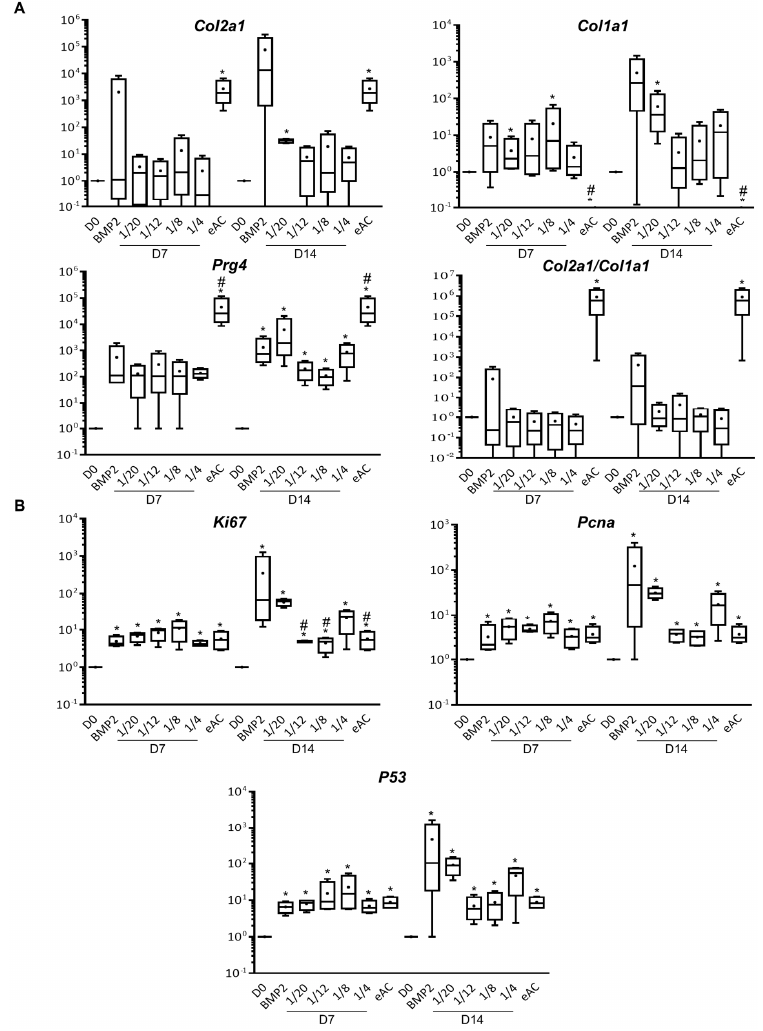
Figure 2. Analysis of eAC mRNA expression of hyaline cartilage and fibrocartilage markers, and proliferation-associated molecules when eACs were seeded in a 3D scaffold and co-cultured with MSCs at different ratios for 7 or 14 days. eACs were seeded in 3D with type I/III collagen sponges at 800,000 cells/sponge. Then, MSCs were seeded in an upper chamber for 7 or 14 days to obtain MSCs/eACs ratios from 1/20 to 1/4. Total mRNA was extracted and RT-qPCR was performed to assess the mRNA levels of hyaline cartilage and fibrocartilage markers (types II and I collagens, and Prg4 ) ( A ) and proliferation- associated molecules ( Ki67 , Pcna , and P53 ) ( B ). The D0 condition corresponds to eACs cultured in monolayer until P3. The eAC condition corresponds to eACs at P0. BMP-2 condition corresponds to eACs cultured in 3D in the presence of BMP-2 (50 ng/mL). mRNA levels were estimated by RT-qPCR after normalization relative to the β - actin reference gene. The results ( n = 4) are represented as box plots (median, quartiles, extreme values) and the statistical significance of the values was tested using the Mann–Whitney test with the D0 condition (* p < 0.05) and the BMP-2 condition (# p < 0.05) as references. Note: 3D-for cells cultured in type I/III collagen sponges; BMP-2-bone morphogenetic protein 2; Col1a1 -gene encoding the alpha1(I) mRNA of type I collagen; Col2a1 -gene encoding the alpha1(II) mRNA of type II collagen; D0-for untreated eACs; D7-time point corresponding to the cells cultured for 7 days; D14-time point corresponding to the cells cultured for 14 days; eACs-equine articular chondrocytes; Ki67 -gene encoding the Ki67 mRNA, MSCs- mesenchymal stem cells; P0-primary culture; P3-passage 3; P53 -gene encoding the P53 mRNA; Pcna -gene encoding proliferating cell nuclear antigen mRNA; Prg4 -gene encoding proteoglycan 4; RT-qPCR-reverse transcription-quantitative polymerase chain